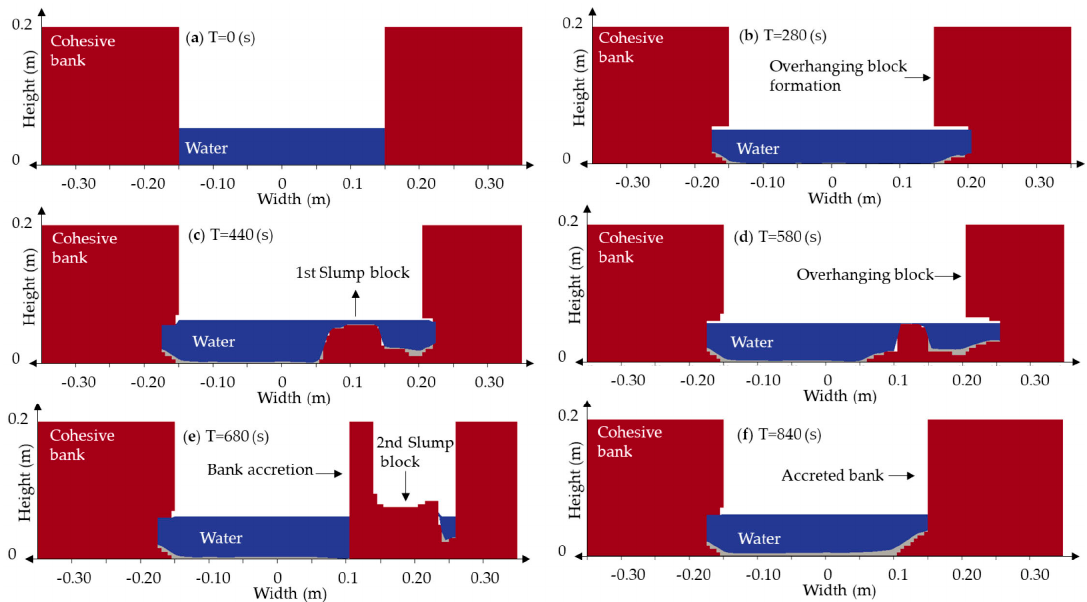
Figure 6. Sequence of bank erosion and bank accretion processes for Case 1: ( a ) Initial section; ( b ) fluvial erosion in the lower part of the bank and overhanging block failure; ( c ) Slump block decomposition; ( d ) widening of the channel; ( e ) accretion starts and ( f ) recovering of the initial bank height (Right: outer bank, left: inner bank).